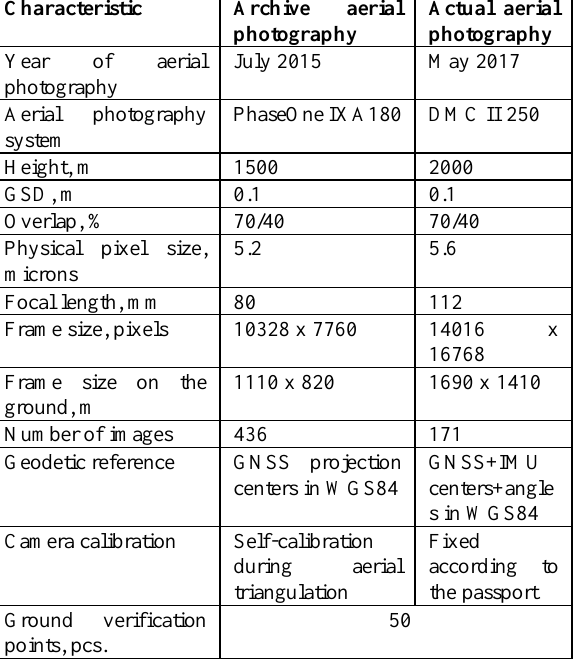
Table 1 . Characteristics of initial aerial photos.